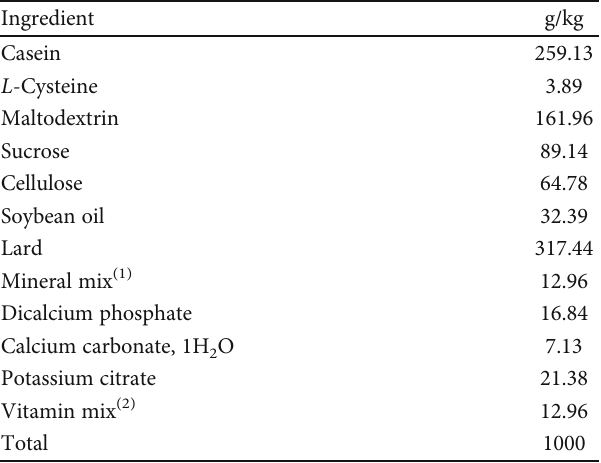
Table 1: Composition of the high-fat